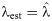
Comparison of the three power-law exponent estimators, LS, MLCSN, and ML*.For 400 values of λ in the range between 0 and 4, we sample N = 10,000 events from Ω = {1, ⋯, 1,000}, from a power-law probability distribution p(x|λ, Ω) ∝ x−λ. The estimated exponents λest for the estimators LS (red), the MLCSN (green, λest=λ^), and the new ML* (black, λest = λ*), are plotted against the true value of the exponent λ of the probability distribution samples are drawn from. Clearly, below λ ∼ 1.5 the MLCSN estimator no longer works reliably. MLCSN and ML* work equally well in a range of 1.5 < λ < 3.5. Outside this range ML* performs consistently better than the other methods. The inset shows the mean-square error σ2 of the estimated exponents. The LS-estimator has a much higher σ2 over the entire region, than the ML*-estimator. The blue dot represents the ML* estimate for the Zipf exponent of C. Dickens’ “A tale of two cities”. Clearly, this exponent could never reliably be obtained from the rank ordered distribution using MLCSN, whereas ML* works fine even for values of λ ∼ 0.